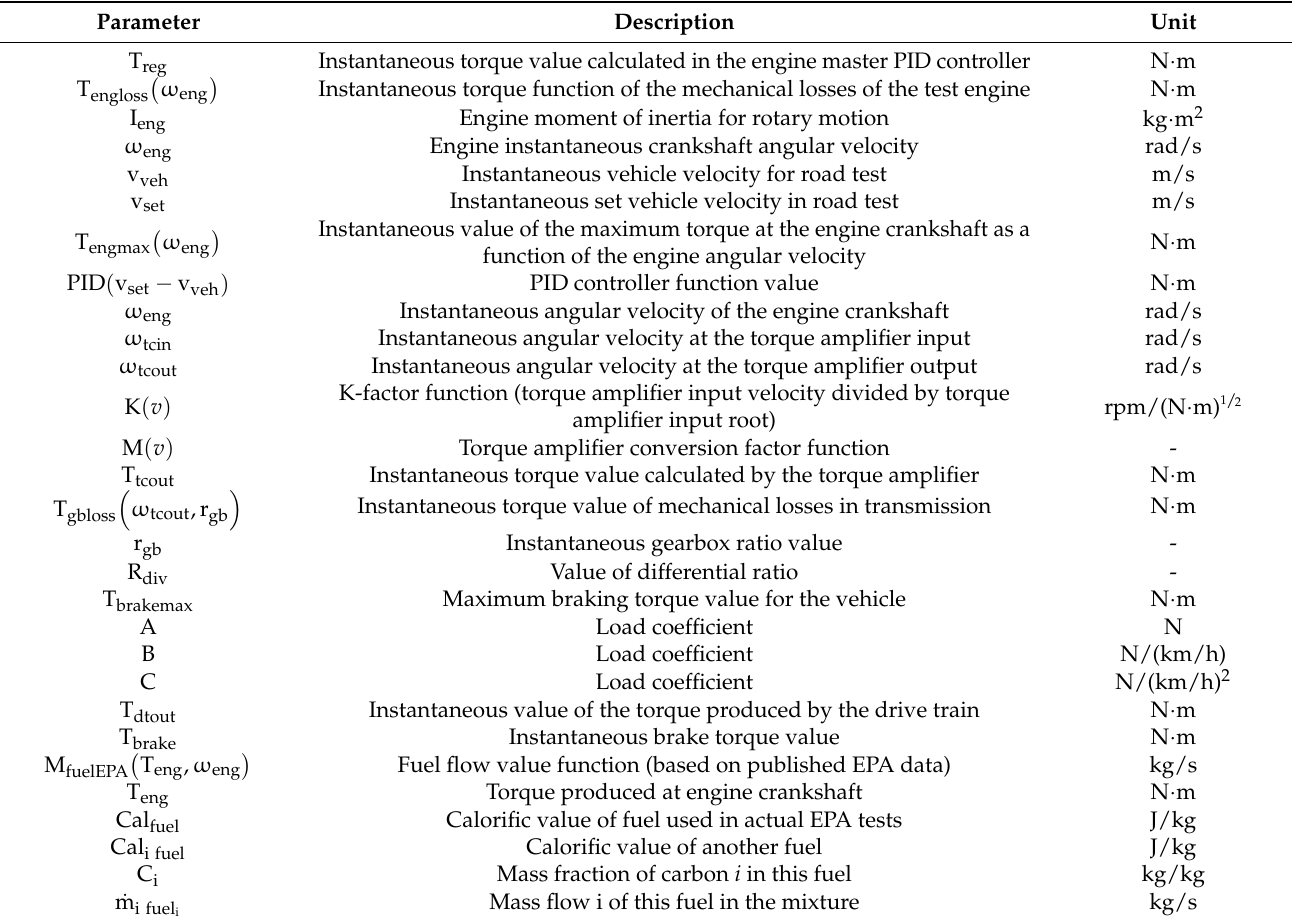
Table 1. Abbreviations, symbols and units used in the paper.